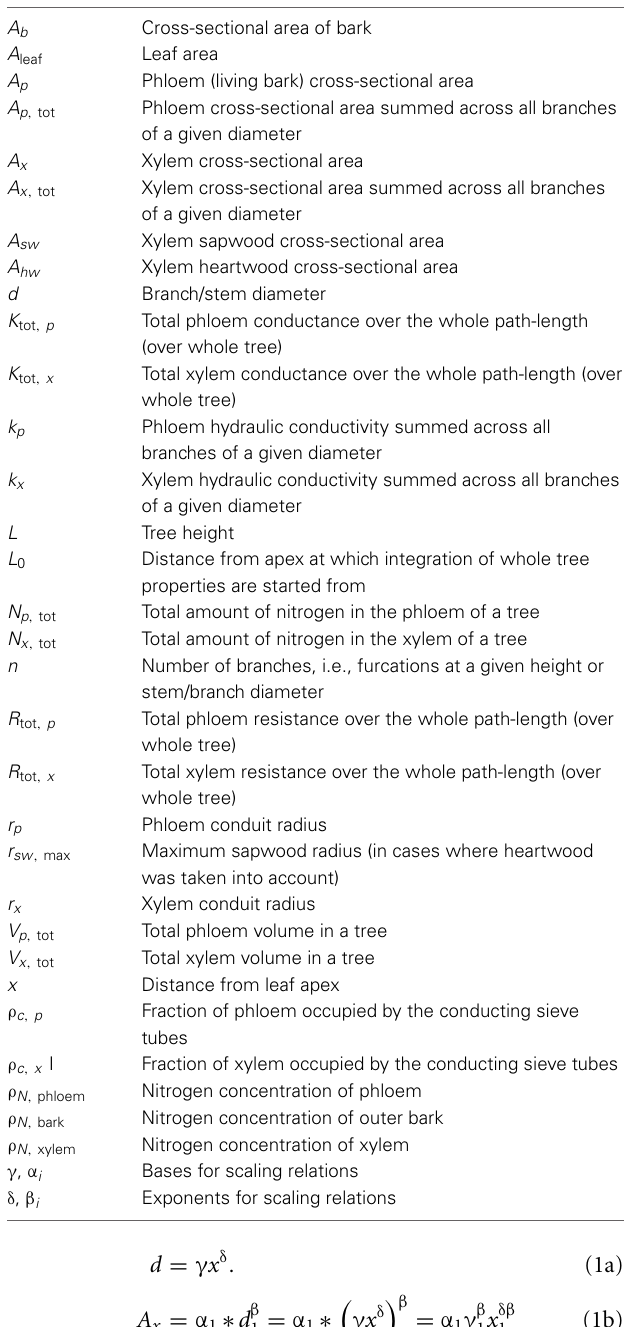
Table 1 | Symbols used in the